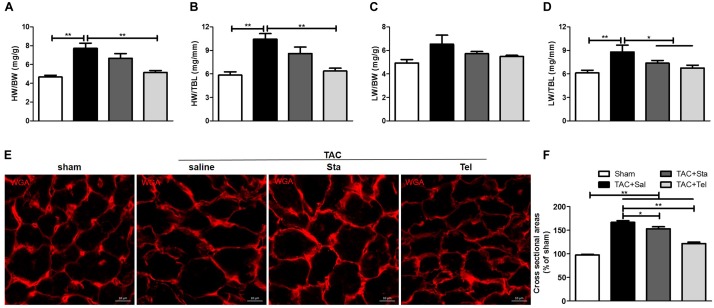
Sta treatment alleviated pressure overload induced cardiac morphological remodeling and pulmonary congestion. (A,B) Quantification of heart weight-to-body weight ratio and heart weight-to-tibial length ratio. (C,D) Quantification of lung weight-to-body weight ratio and lung weight-to-tibial length ratio. (E) Representative immunofluorescence images of cross sectional area of cardiomyocyte by WGA (magnification ×100), scale bar: 10 μm. (F) Mean cross sectional area were quantified by the image-J cell area measurement software, and at least 30 cardiomyocytes per animal in each group were measured. Animal heart samples were collected at 4 weeks after surgery. The data were expressed as the mean ± SEM. ∗∗P < 0.01; ∗P < 0.05; n = 6–8 in each group; TAC, transverse aorta constriction; Sal, saline; Sta, stachydrine; Tel, telmisartan; HW, heart weight; BW, body weight; TBL, tibial length; WGA, wheat germ agglutinin.